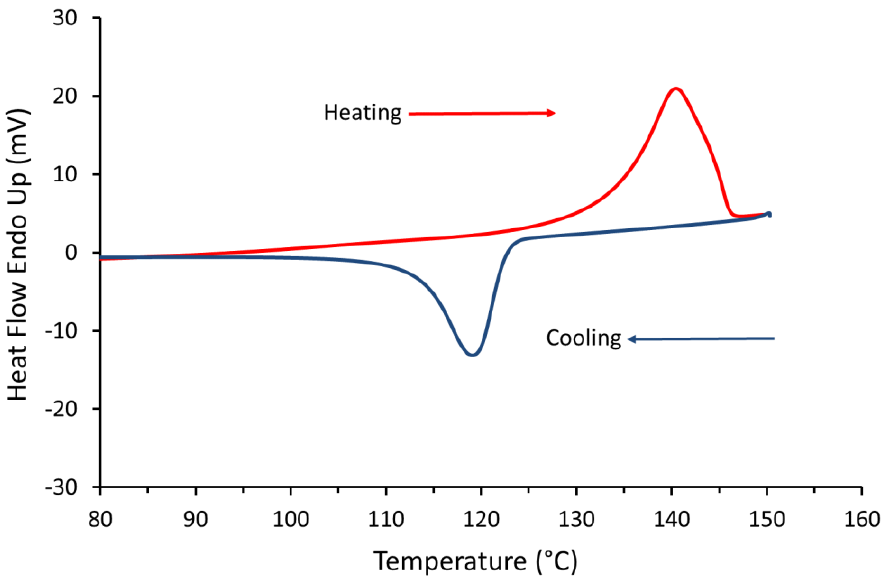
Figure 13. DSC curve of UHMWPE powder heated to 150 °C.